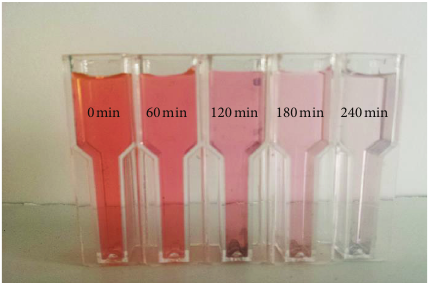
Figure 7: Photographs of eosin Y after treatment with the synthe- sised Ag-Fe 3 O 4 powder at different time intervals; the colour of eosin Y solution faded, indicating degradation of the dye.